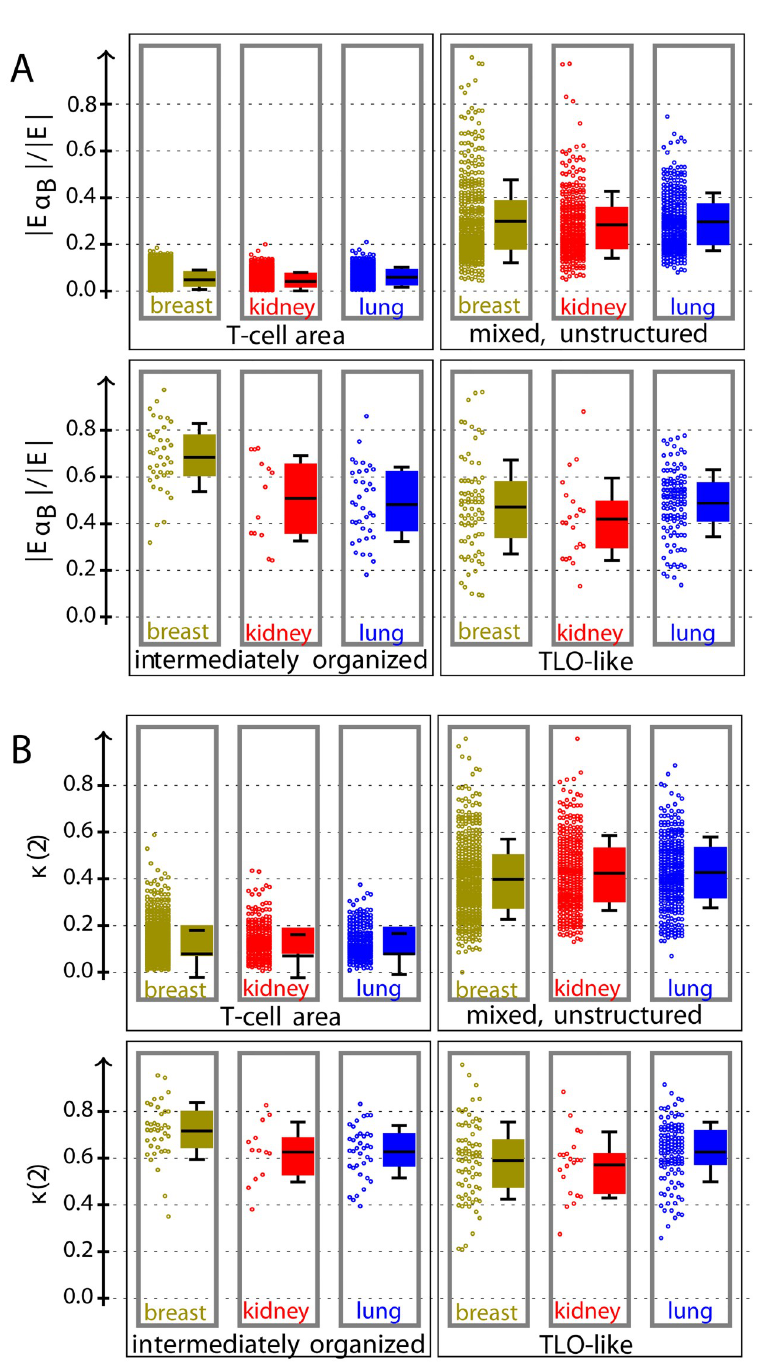
Fig 6. Distribution of relative number of edges between B-cells (A) and organization (B): Gray border represents significant difference between corresponding class and all remaining classes of same tissue type by Mann– Whitney U test using a significance level of 0.001. Each distribution is displayed as raw data (left) and a box plot (right) with mean (line), quartiles (color box), and standard deviation. The TLO-like organization κ measures the number of edges between T- and B-cells that are connected to a B-cell cluster, see Eq (1).